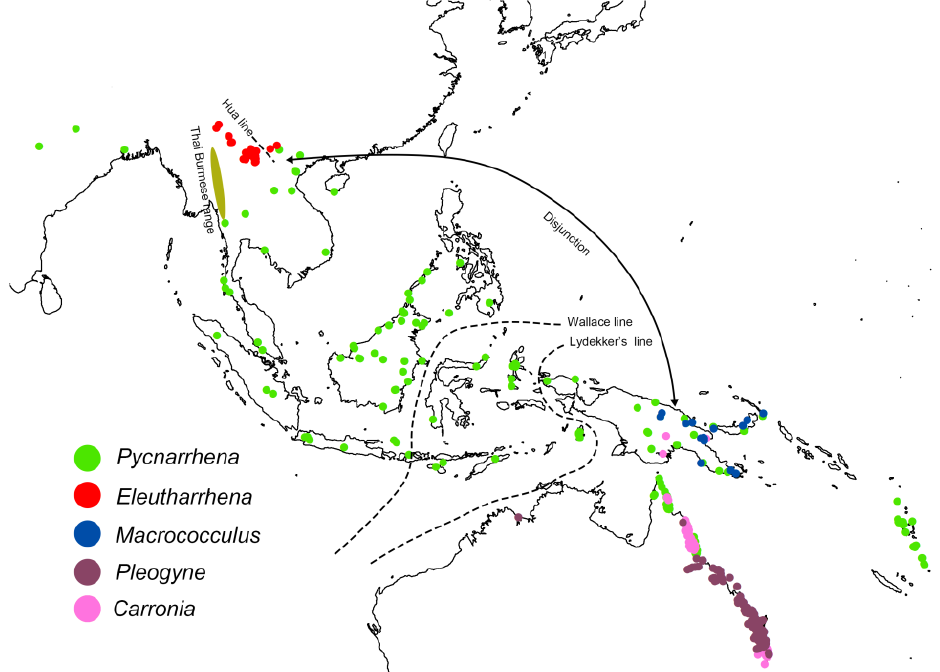
Figure 1. Distribution map of Eleutharrhena and sister genera Macrococculus , Pycnarrhena , Pleogyne, and Carronia . Distribution records downloaded from GBIF except for Eleutharrhena macrocarpa records. Eleutharrhena is a sister to Pycnarrhena [5] and is morphologically similar to